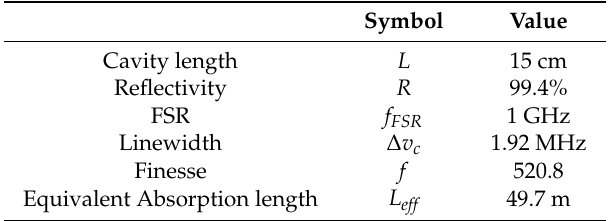
Table 1. Basic specifications of the designed cavity. FSR, free spectral